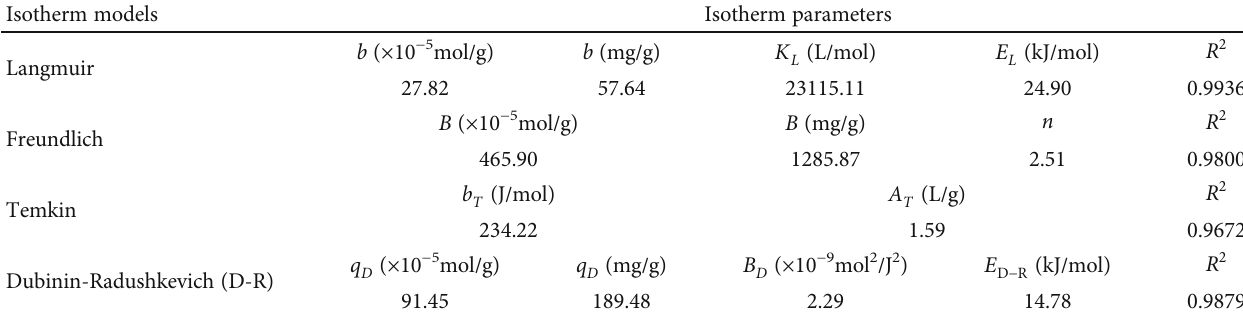
Table 3: Isotherm parameters of Pb(II) adsorption onto MHDHA.